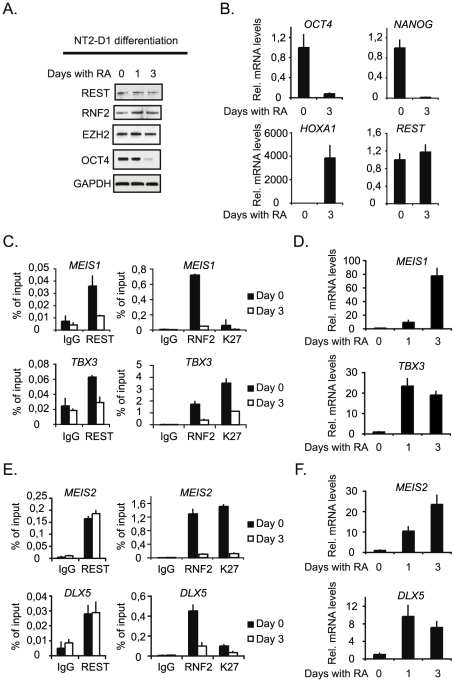
Neuronal differentiation in NT2-D1 cells.NT2-D1 cells were treated with Retinoic Acid (RA) for 1 and 3 days or left untreated (day 0). Protein-, RNA- and ChIP-samples were harvested. (A) Western blot analysis of protein samples taken at day 0, 1 and 3. (B) Relative mRNA levels at day 0 and 3 of REST, OCT4 and NANOG and HOXA1. (C) Group of genes, which loose binding of both REST and PcG proteins during differentiation. ChIP analysis was performed for day 0 and 3 of RA treatment. (D) Relative mRNA levels of the genes displayed in (C), for untreated cells and cells treated with RA for 3 days. (E) Group of genes, which maintain REST binding but loose PcG proteins during differentiation. ChIP analysis at day 0 and 3 after RA treatment. (F) Relative mRNA levels of the genes displayed in (E) after 0 and 3 days of RA treatment. Error bars represent standard deviations calculated from triplicate qPCR reactions.